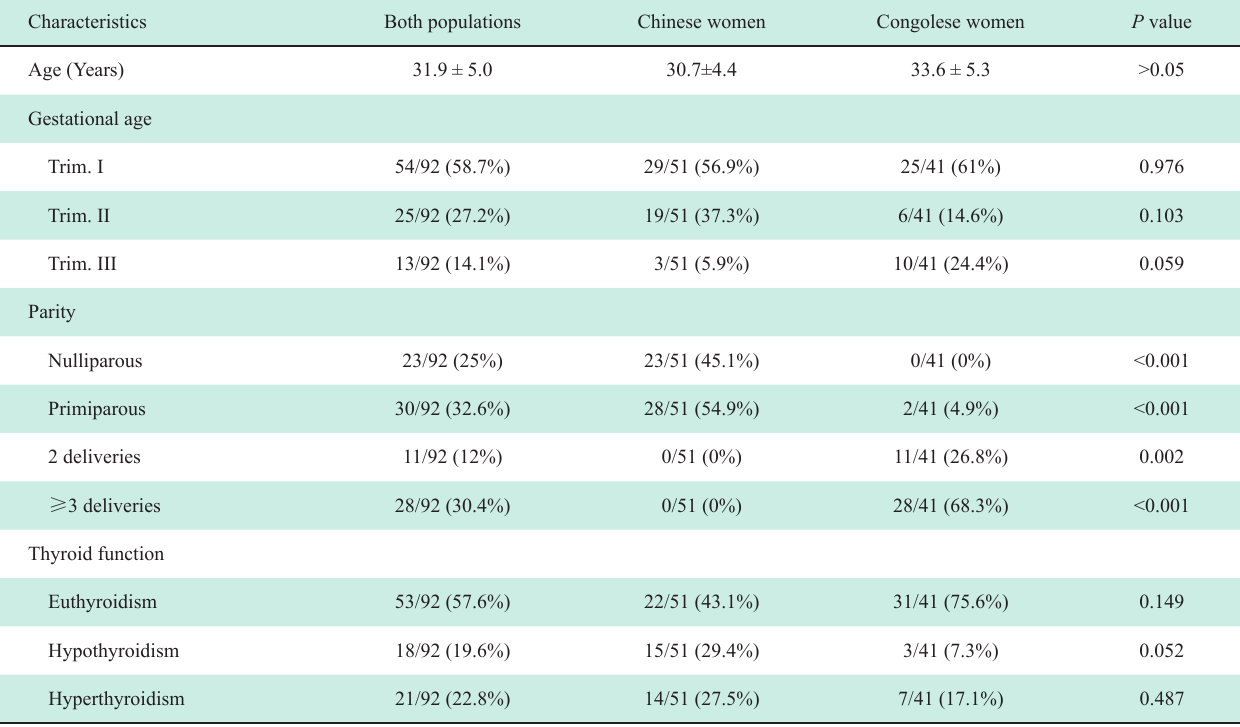
Table 1 Epidemio-clinical characteristics of the study women Characteristics Both